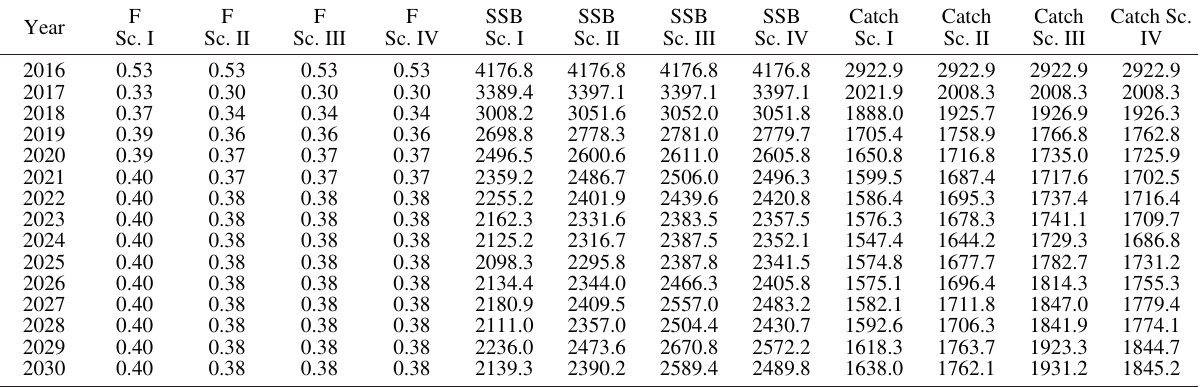
Table 4. – Summary of the main Gadget outcomes of HKE after survey with forecast from 2017 to 2030: F, SSB and Catch (expressed in metric tons) between trawl nets (Sc. I, Scenario I; Sc. II, Scenario II; Sc. III, Scenario III; Sc. IV, Scenario IV).